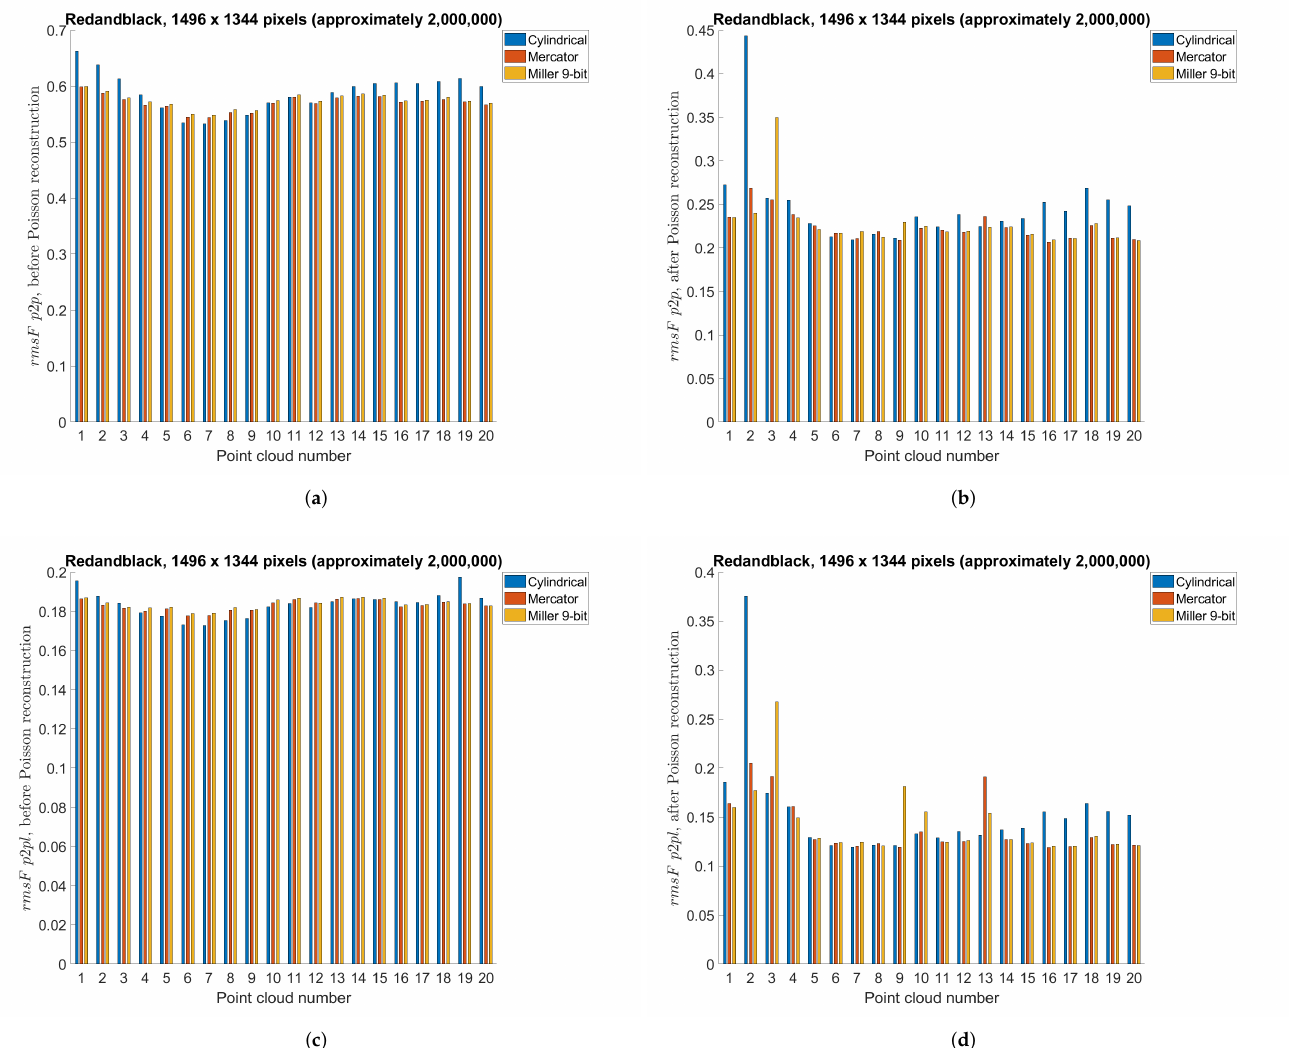
Figure 18. Point-to-point and point-to-plane objective measure ( rmsF p2p ) per Redandblack point cloud, using cylindrical, Mercator and Miller 9-bit depth projections with approximately 2,000,000 points: ( a ) point-to-point, before Poisson reconstruction; ( b ) point-to-point, after Poisson reconstruction; ( c ) point-to-plane, before Poisson reconstruction; ( d ) point-to-plane, after Poisson